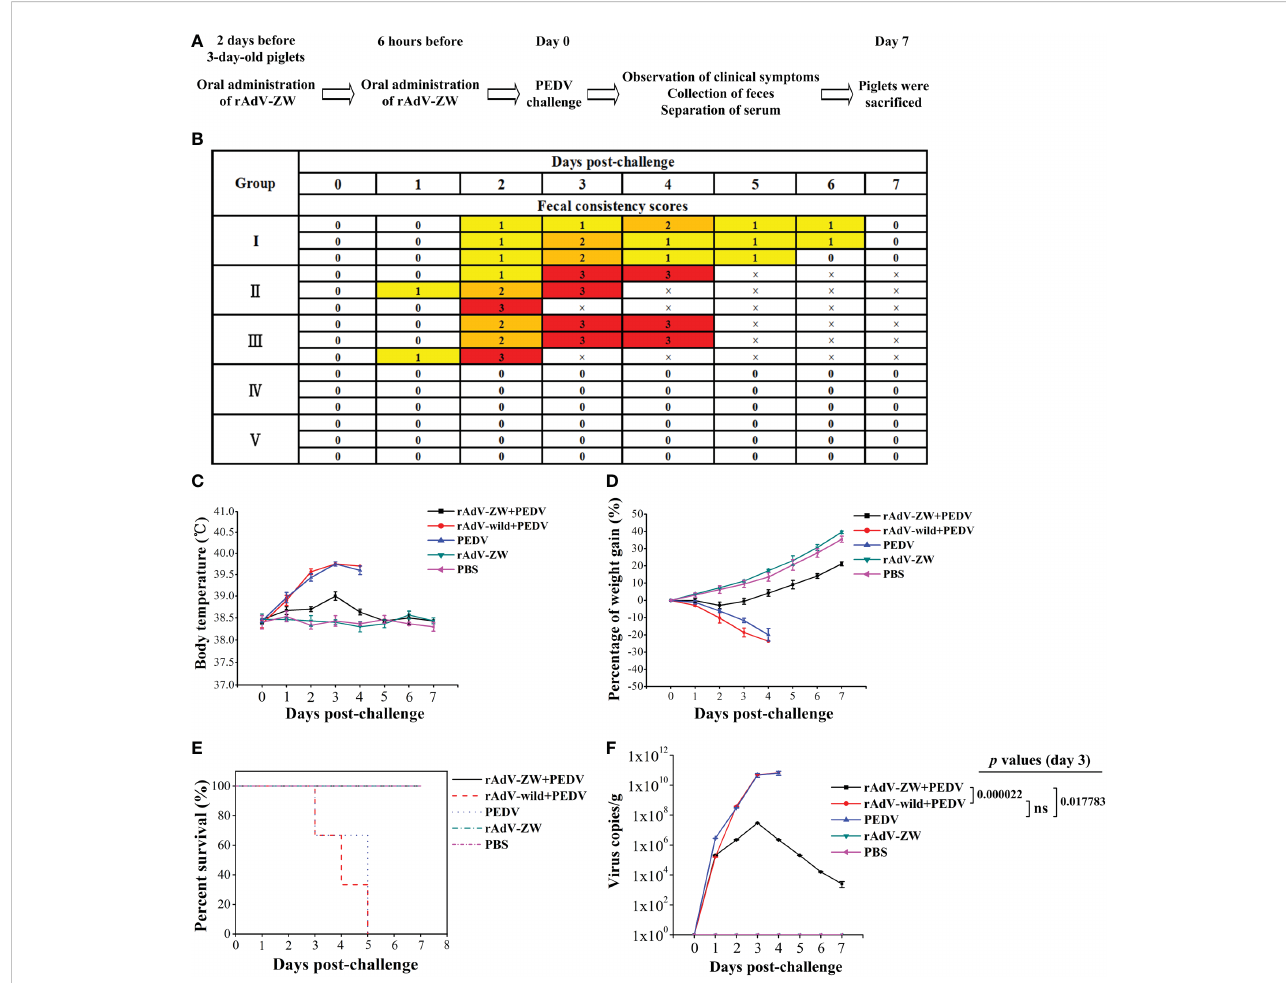
FIGURE 5 Evaluating the protective effects of scFvs on PEDV-induced diarrhea in piglets. (A) Experimental design showing the oral administration of rAdV-ZW, PEDV challenge, and how we evaluated protective effects in piglets. (B) After PEDV challenge, fecal consistency scores were measured to evaluate the effects of rAdV- ZW on diarrhea severity. Fecal consistency was evaluated using a 0-3 scoring scale: 0 = solid feces; 1 = pasty feces; 2 = semi-liquid feces; and 3 = liquid feces. (C) Effects of rAdV-ZW on rectal temperatures of piglets challenged with PEDV. Rectal temperatures, induced by PEDV in piglets via the oral administration of rAdV-wild-type or PBS, were signi fi cantly increased; the highest temperature was approximately 40°C, and rAdV-ZW administration delayed and attenuated increased rectal temperatures induced by PEDV in piglets. (D) Piglet weight gain percentages during studies. Piglets were weighed before PEDV challenge and at 7 dpc, with weight gain percentages shown. PEDV-infected piglets upon oral rAdV-wild-type or PBS administration lost approximately 20% of their body weight. (E) Piglets were observed for 7 days after challenge to assess the effects of rAdV-ZW on survival rates. After PEDV infection, piglets orally administered rAdV-wild- type or PBS died, while those orally administered rAdV-ZW survived. (F) PEDV feces quanti fi cation; fecal samples were collected daily and viral RNA extracted to analyze PEDV production by RT-qPCR using speci fi c PEDV M gene primers. Values were presented as the mean ± standard error of the mean (SEM). Ns = not signi fi cant (P >